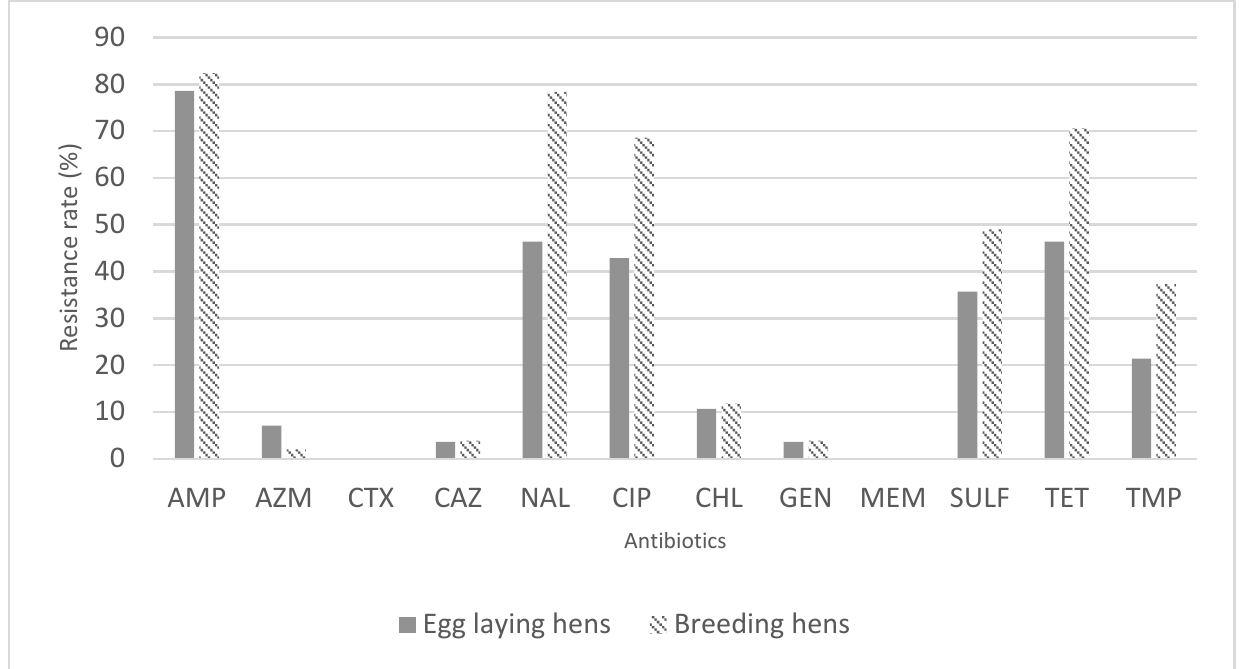
Figure 1. Percentage of resistance to the antimicrobials under study, for feces isolates of E. coli from egg laying hens or breeding hens.